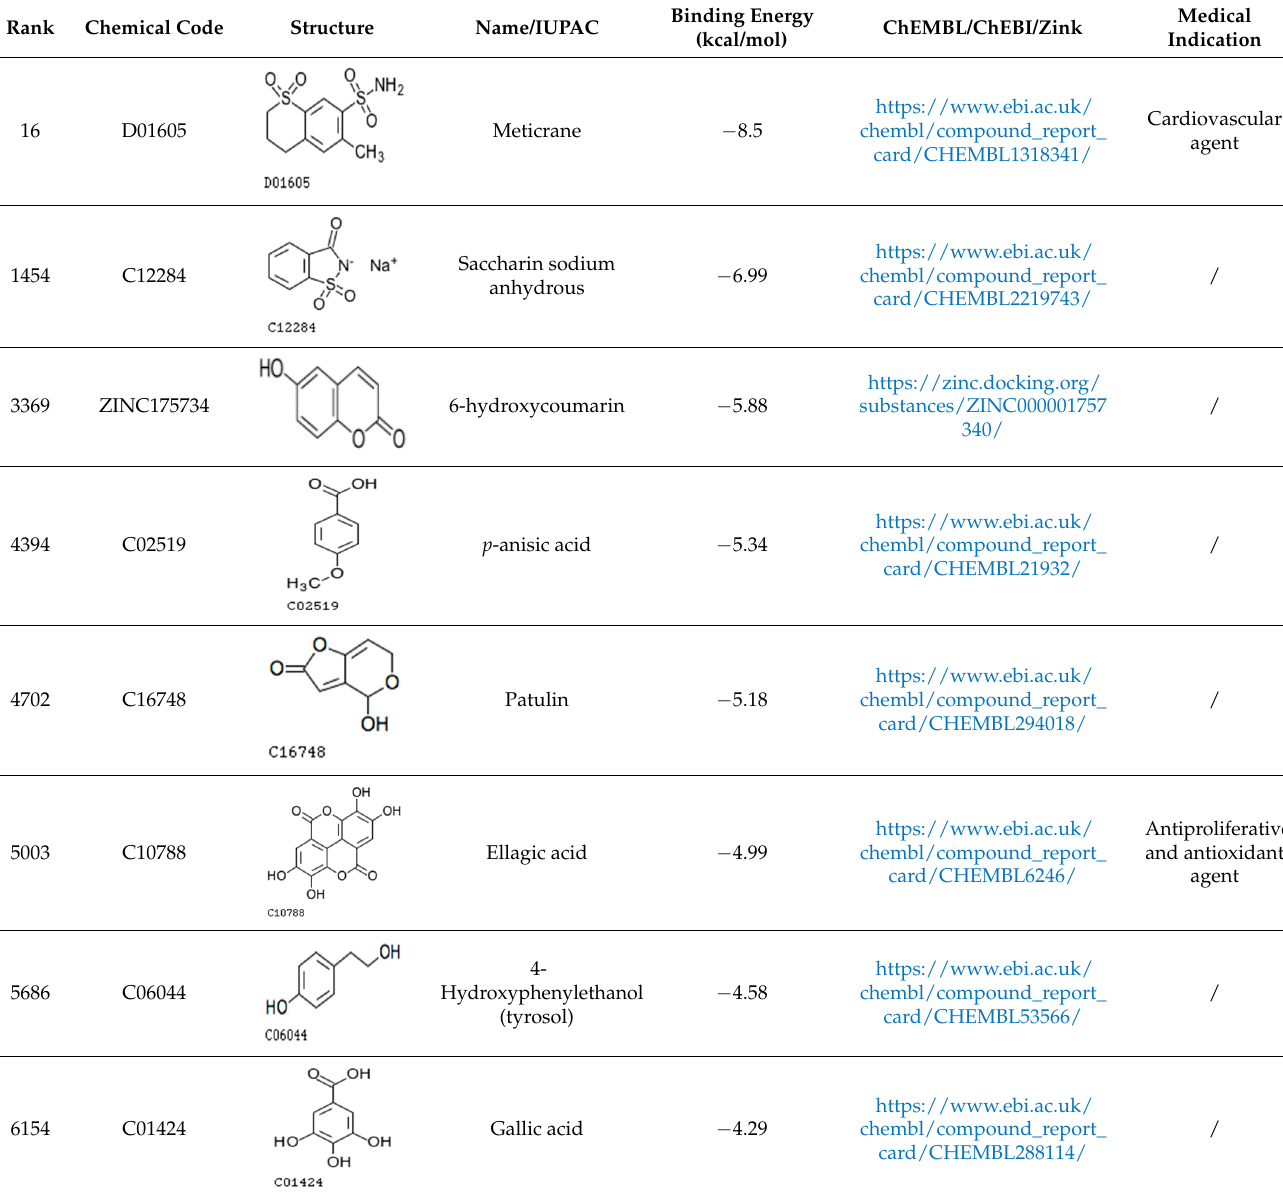
Table 1. List of the seven ligands selected for evaluating in in vitro/in vivo assays their ability in reducing patulin (also reported in the table) production. Ligands are sorted by binding energy. “Binding energy” stays for the energy of the lowest energy conformation in the largest cluster identified among autodock runs. 2D structures of the assayed ligands are also reported.